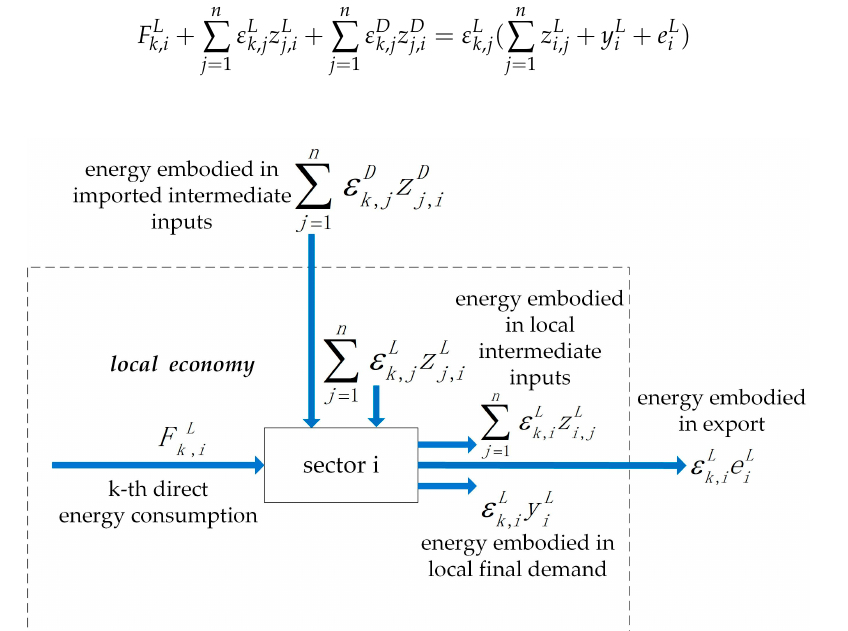
i in an economic system (with the k -th type of